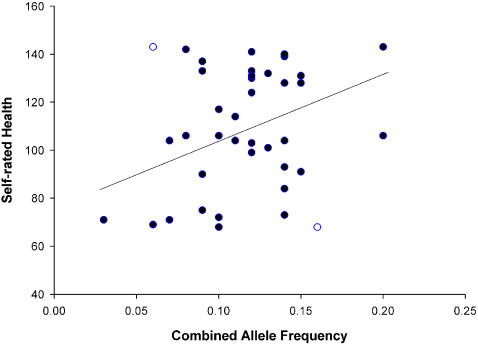
The relationship between combined allele frequency and self-rated health.Outliers are indicated as open circles.